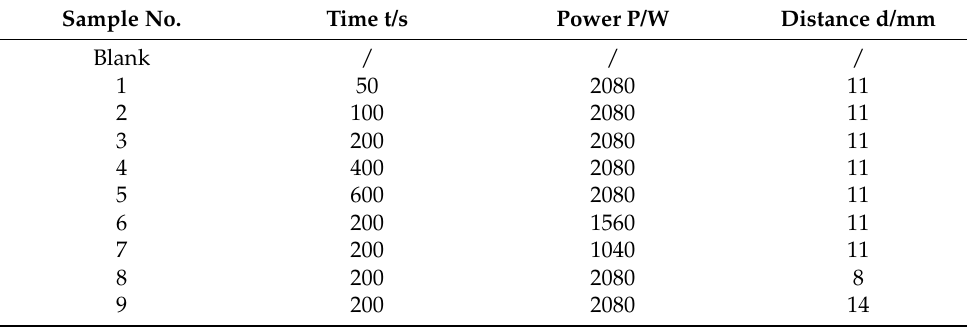
Figure 1. Ultrasonic shot peening equipment diagram. Table 3. Ultrasonic shot peening experimental parameters.